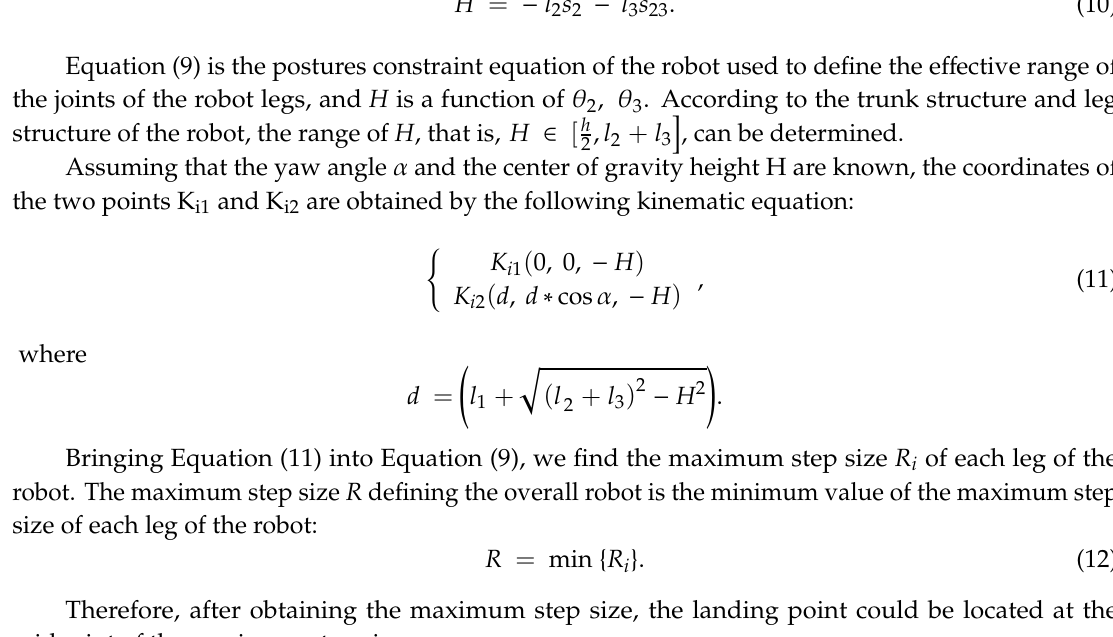
Figure 10. Joint angle θ 2 and θ 3 when M is minimum under different center of gravity heights.